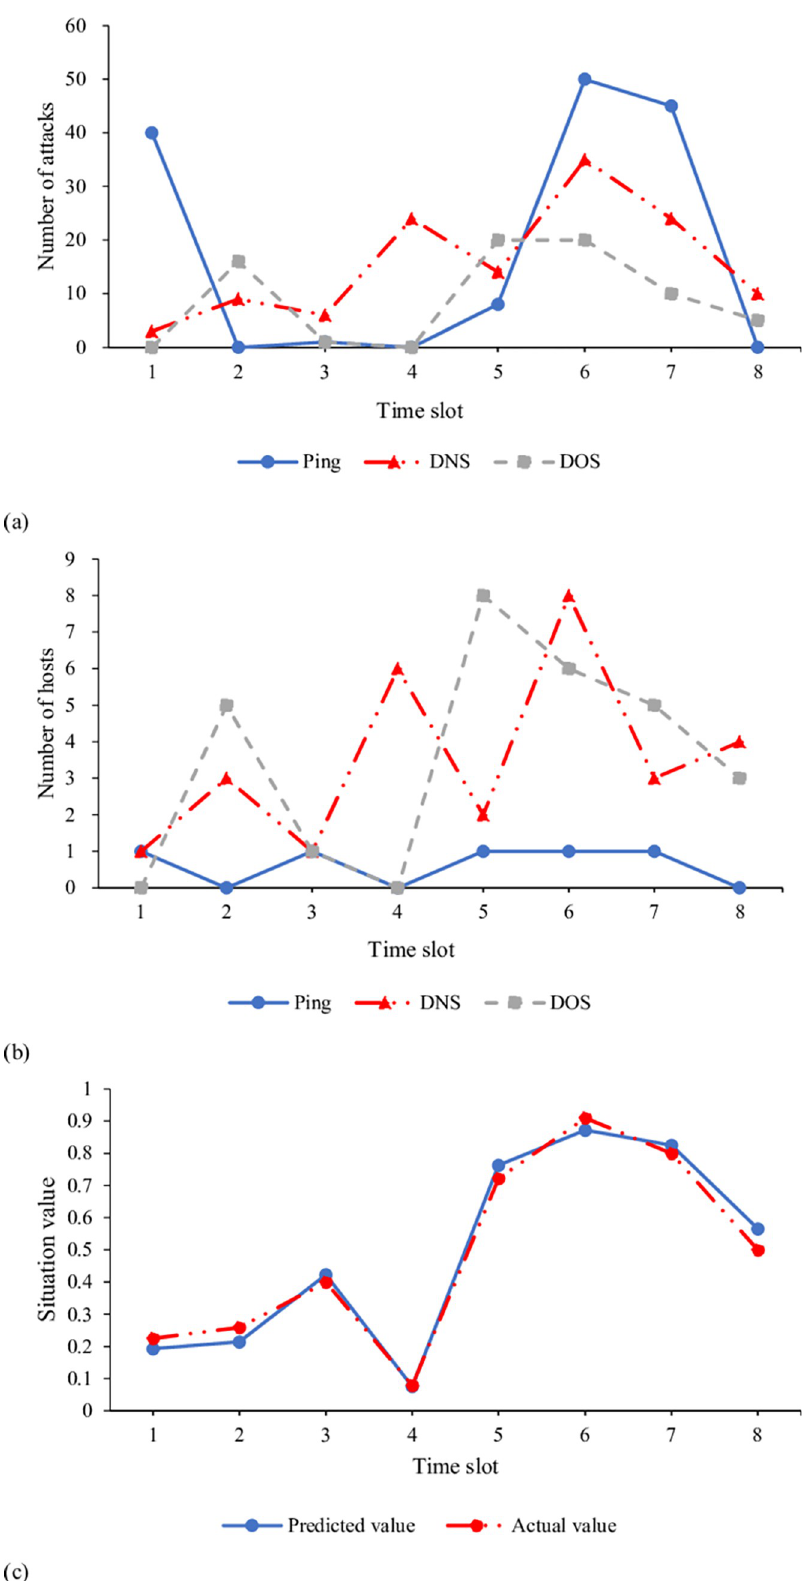
Fig 9. Results of GRG-based CAM (a. number of cyberattacks; b. number of hosts attacked; c. CSI).